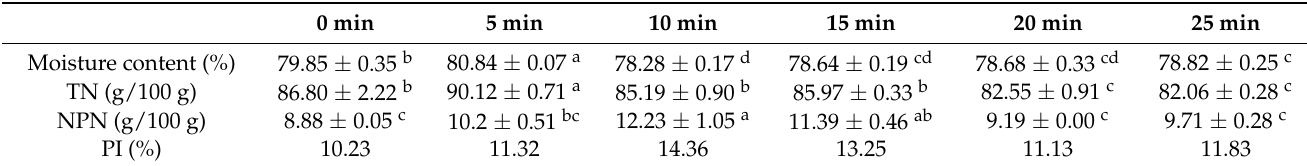
Table 2. Changes of moisture, total nitrogen, and non-protein nitrogen content in swimming crab meat during